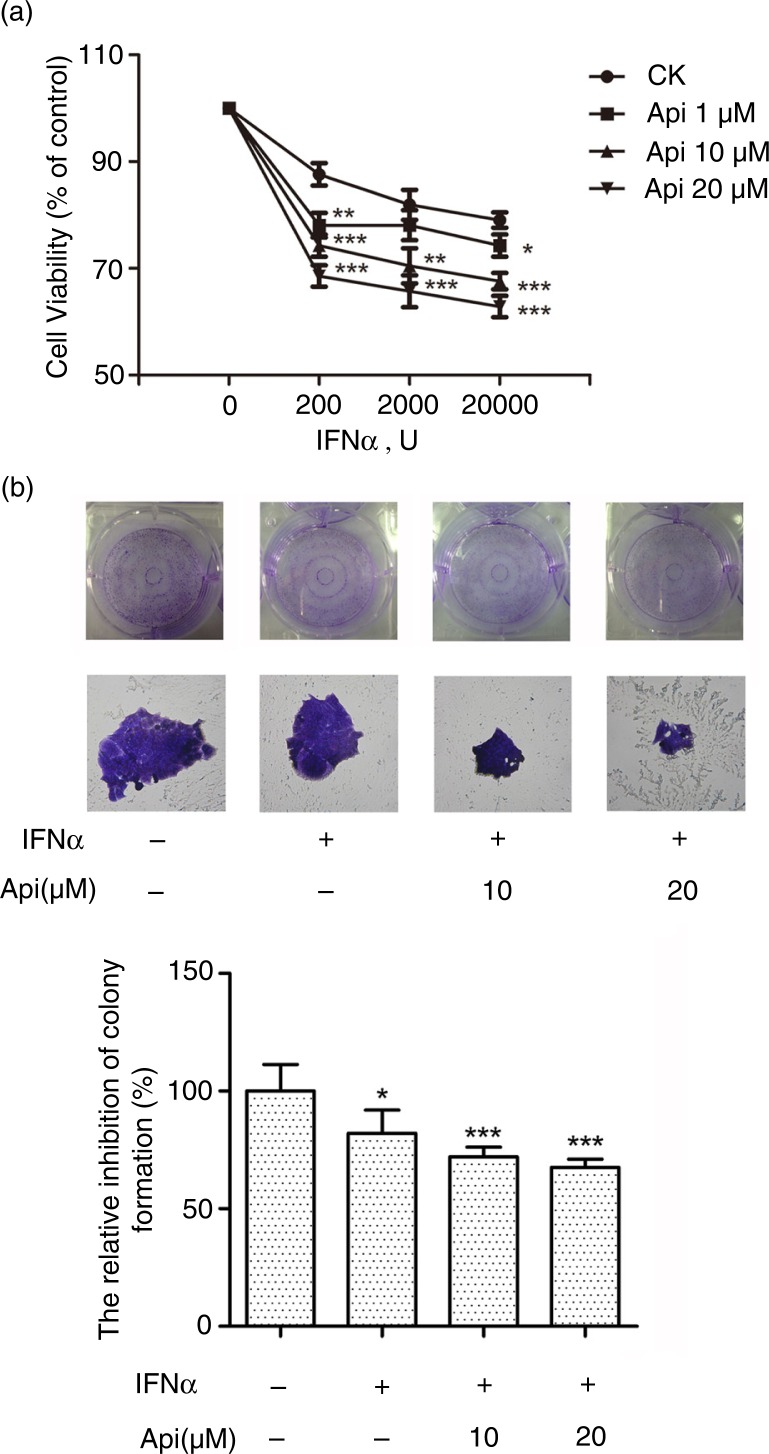
Apigenin potentiates the inhibitory effect of IFN-α on cancer cell viability. (a) The HeLa cells (5×103 cells/well) were seeded in 96-well plates and treated under indicated concentrations of apigenin and IFN-α for 72 h. Cell viability was measured by Alamar Blue assay and the values are expressed as the percentage cell viability relative to the DMSO control. (b) The HeLa cells growing in 6-well plates were treated with the indicated concentrations of apigenin and IFN-α (1×104 U/mL) for 12 days, and then colonies were visualized by staining with crystal violet and counted manually. The bar graph was obtained by calculating the percentages of colony numbers from each well relative to the DMSO-treated control. (*) p<0.05, (**) p<0.01, (***) p<0.001 versus control (n=3).